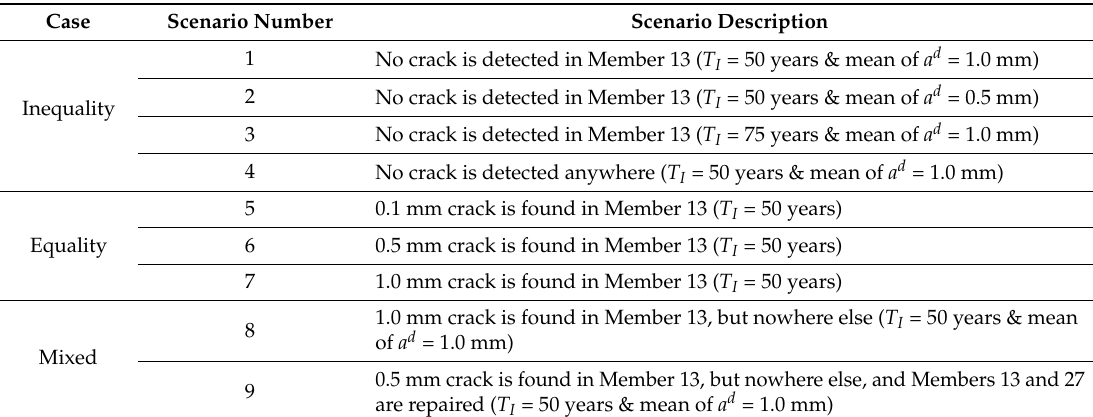
Table 3. Hypothetical scenarios of inspection and repair.